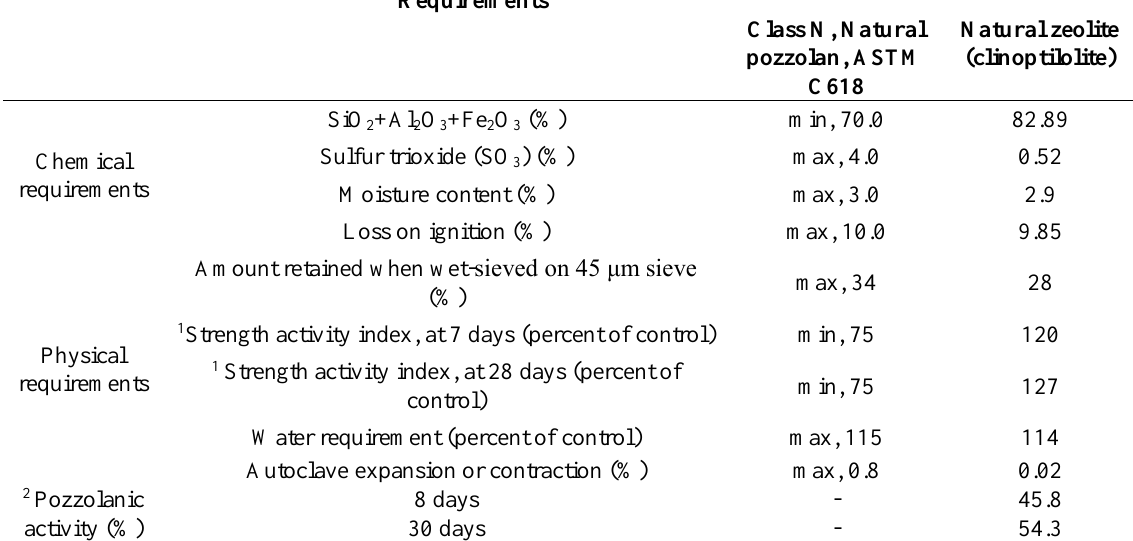
Table 3. Chemical and physical properties of natural zeolite according to ASTM